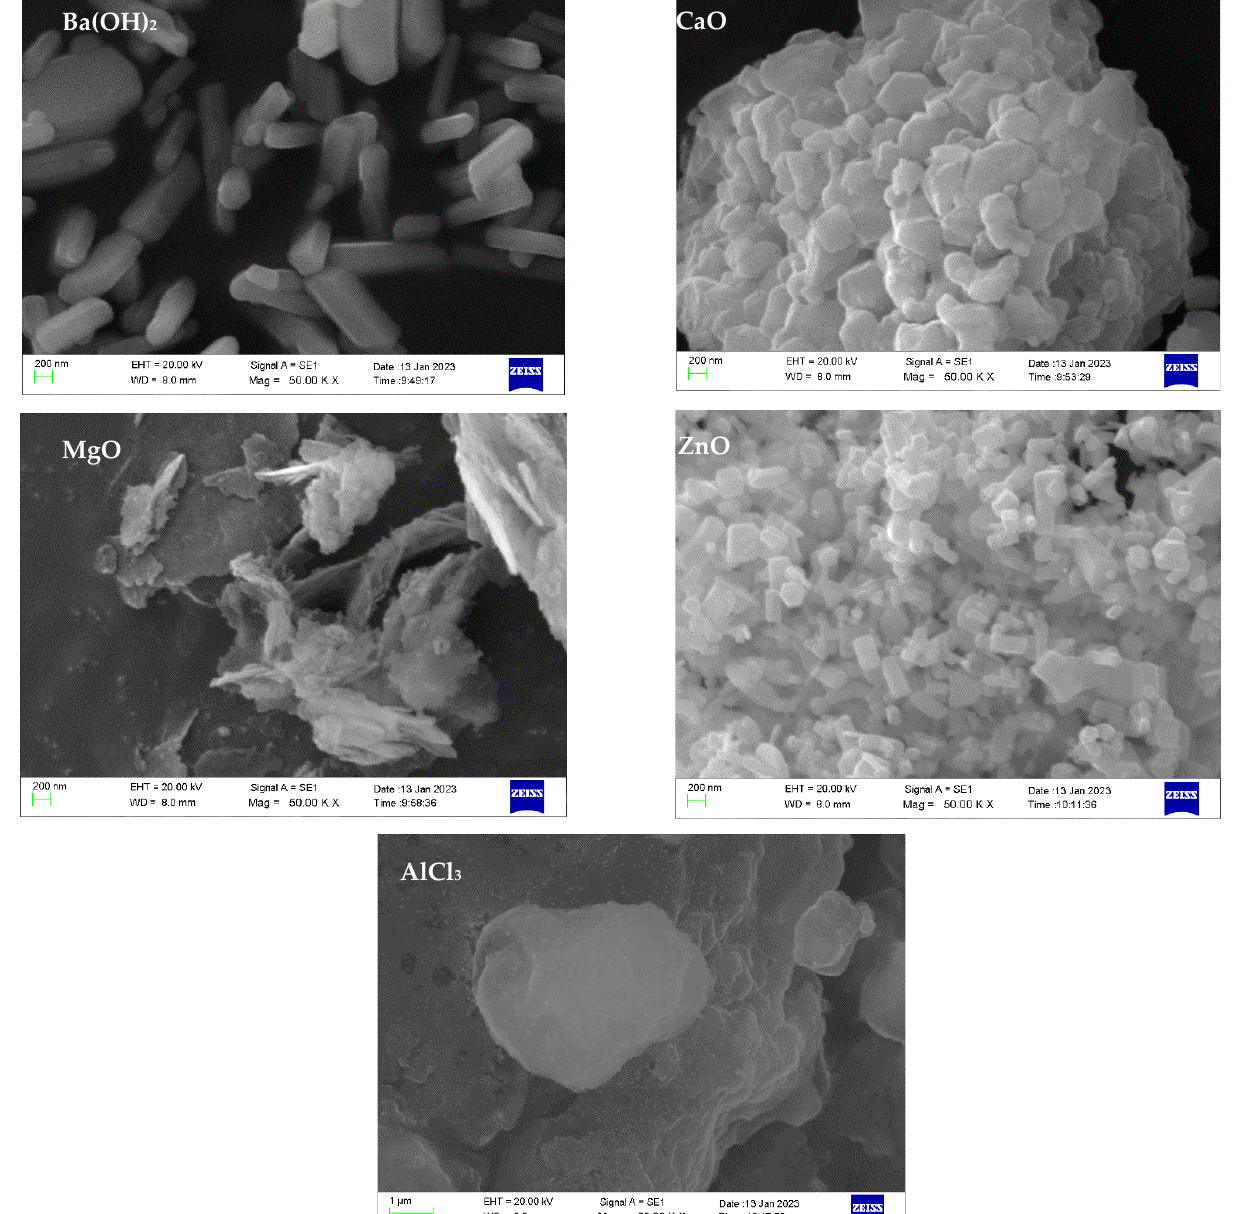
Figure 10. SEM micrographs of Ba(OH) 2 , CaO, MgO, ZnO (50.00 K X), and AlCl 3 (25.00 K X). X-ray powder diffraction (XRD) studies were carried out to confirm the crystallinity using an X-ray diffractometer in the range of 0 – 90° to determine their crystal structure and phase. A typical XRD spectrum of Ba(OH) 2 is shown in Figure 11. This spectrum has four peaks that can be detected at angles of 15.280°, 30.667°, 46.635°, and 63.635°. The dif- fraction peaks of Ba(OH) 2 can be matched with standard Joint Committee on Powder Dif- fraction Standards (JCPDS) data [JCPDS file: 00-026-0154]. Figure 12 depicts a typical XRD spectrum of CaO; there are five peaks in this spectrum, and they can be found at angles of 32.248°, 37.400°, 53.906°, 64.196°, and 67.423°, respectively. The diffraction peaks of CaO can be matched with CPDS data [JCPDS file: 00-0 70-4068]. Figure 13 illustrates a typical XRD spectrum of MgO. Six diffraction peaks were seen at angles of 18.089°, 36.897°, 42.837°, 62.146°, 74.461°, and 78.454°. The diffraction peaks of MgO can be matched with JCPDS data [JCPDS file: 45-0946]. The XRD spectra indicate that the ZnO crystal is as